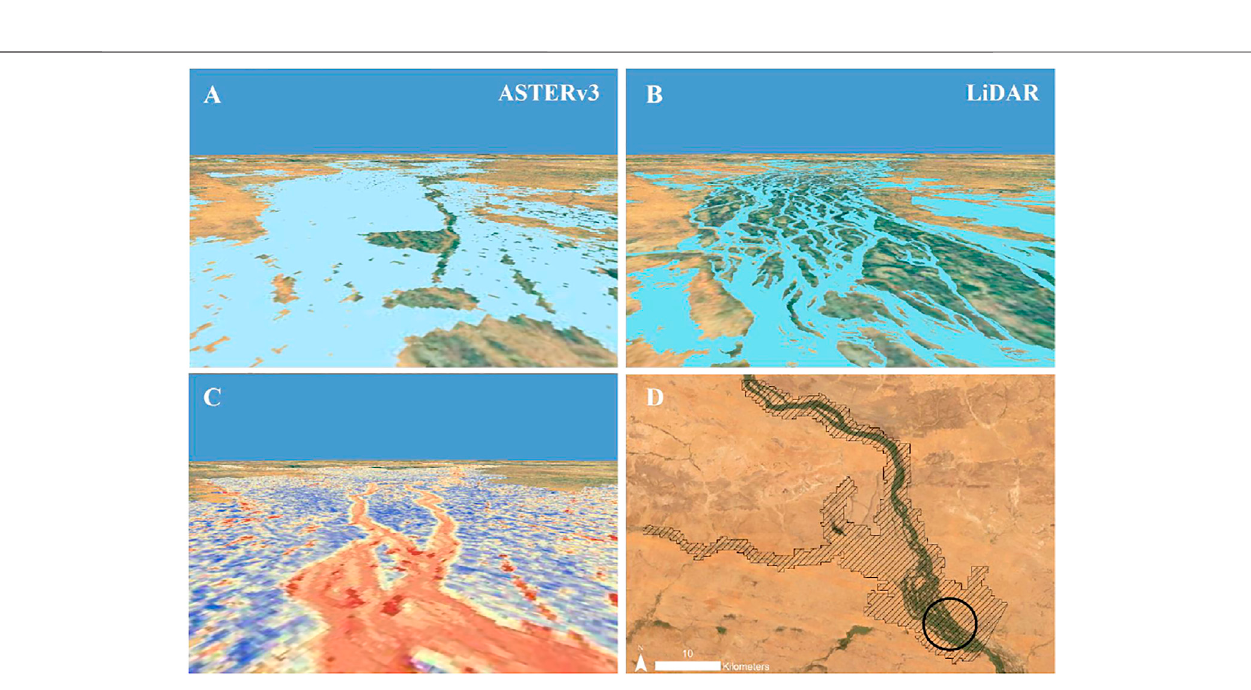
Frontiers in Environmental Science |